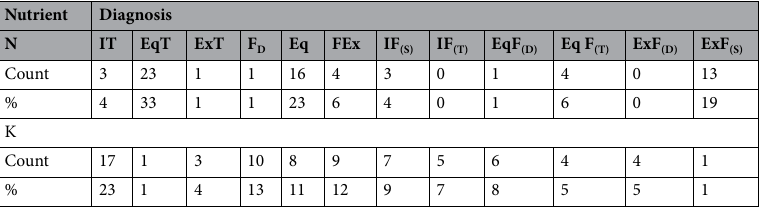
Table 5. Counting of the nutritional diagnosis for potassium and nitrogen nutrients determined by DRIS standards in bananas ( Mussa spp). IT count of the number of true diagnoses for nutritional insufficiency, EqT count of the number of true diagnoses for nutritional balance, ExT count of the number of true diagnoses for nutritional excess, IF (S) count of the number of false diagnoses for insufficiency in situations of recognized nutritional sufficiency, IF (T) count of the number of false diagnoses for insufficiency in situations of recognized nutritional toxicity, EqF (D) counting the number of false diagnoses for balance in situations of recognized nutritional deficiency, EqF (T) count of the number of false diagnoses for balance in situations of recognized nutritional toxicity, ExF (D) count of the number of false diagnoses for excess in situations of recognized nutritional deficiency, ExF (S) count of the number of false diagnoses for excess in situations of recognized nutritional sufficiency, F (D) count of the number of false diagnoses for excess in plants with nutritional deficiency, Eq total diagnoses for nutritional balance, FEx total diagnoses for nutritional excess.